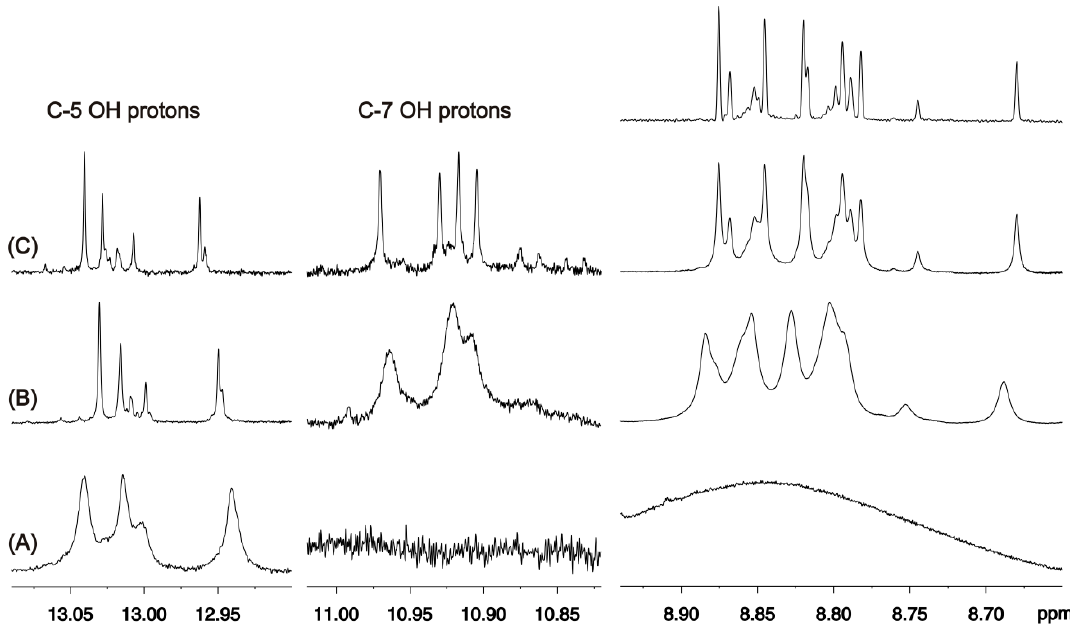
Figure 22. Selected regions of the 500 MHz 1D 1 H-NMR spectra of 20 mg of an olive leaf methanol extract in 0.6 mL of DMSO- d (T = 288 K): ( A ) without the addition of picric 6 acid; ( B ) with a mass ratio of [picric acid]/[extract] of 49.3 × 10 − 3 ; ( C ) the same solution as in ( A ) with a dilution factor of 8 and mass ratio of [picric acid]/[extract] of 49.4 × 10 − 3 ; upper trace, the same spectrum as in ( C ) with the application of Lorentz-to-Gauss transformation. Reproduced with permission from [16]. Copyright 2011, by the